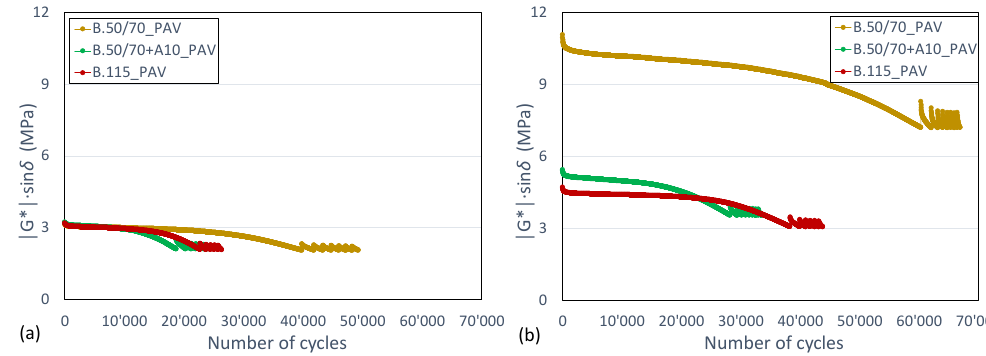
Figure 6. Comparison among aged binders in ( a ) iso-stiffness and ( b ) iso-thermal condition in terms of evolution of |G ∗ | ∙ sin δ versus number of loading cycles.